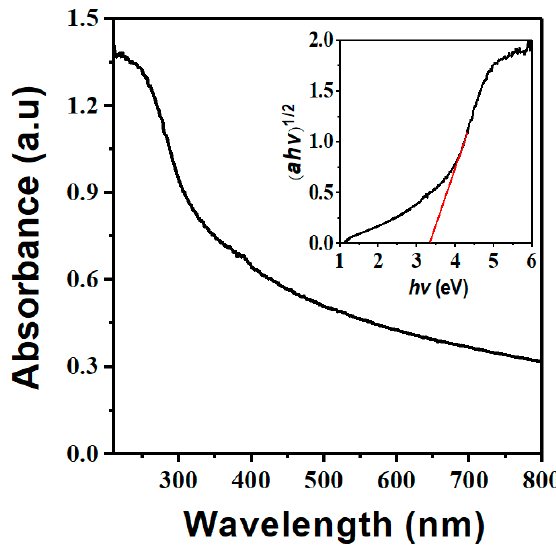
Figure 4. UV/Vis DRS and Tauc plots of of Nb 2 O 5 .